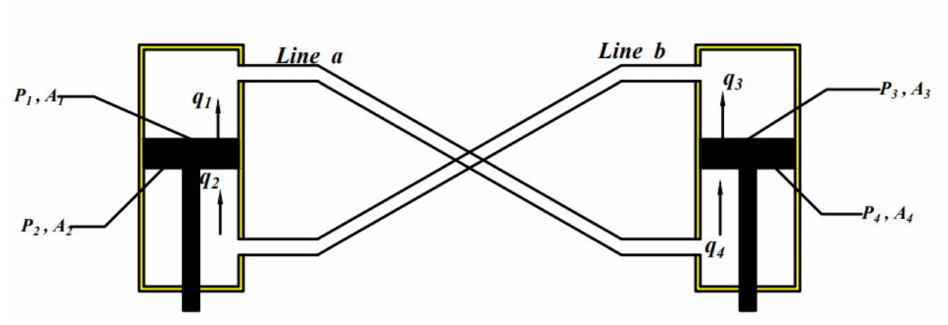
Figure 4. Schematic of a general anti-oppositional half-car HIIRS